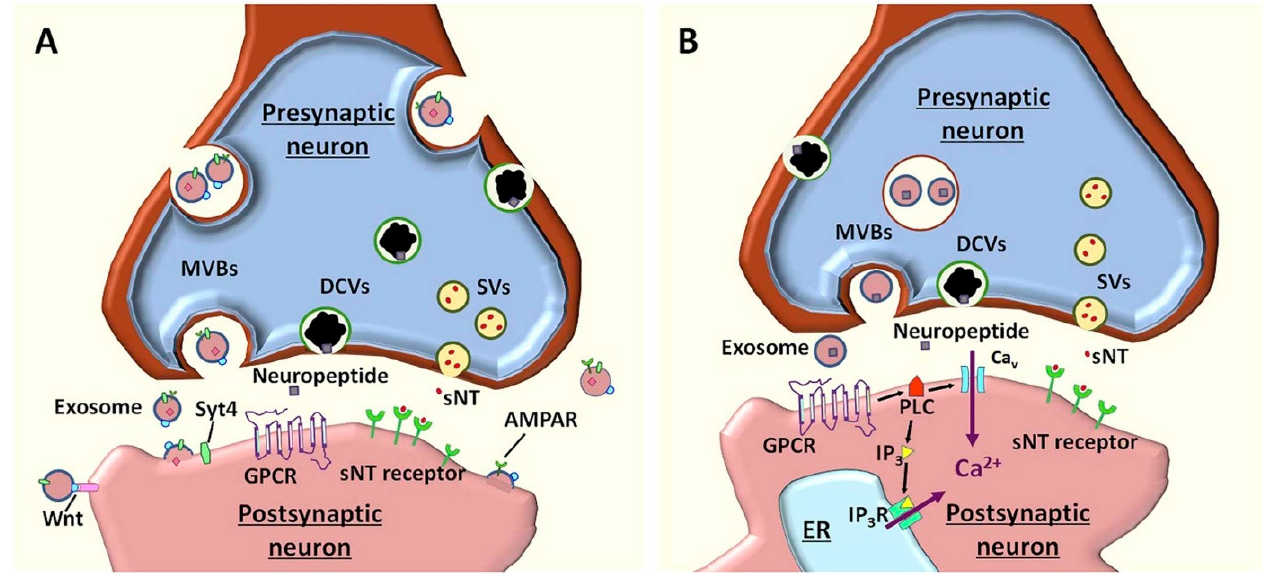
Figure 3. ( A ) Schematic representation of the function of neuronal exosomes as neuromodulators. In neurons, MVBs fuse with the plasma membrane without being restricted to the synaptic specialization and release exosomes into extracellular spaces, including the synaptic cleft. Through their various cargos, exosomes regulate synaptic plasticity. ( B ) The proposed models for neuronal exosomes as neurotransmitters. In response to action potentials, exosomes are released from the presynaptic neuron. As they carry neuropeptides and other ligands, exosomes activate GPCRs and downstream signaling cascade, leading to Ca 2+ release from ER. Reprinted from an open-access source [1].